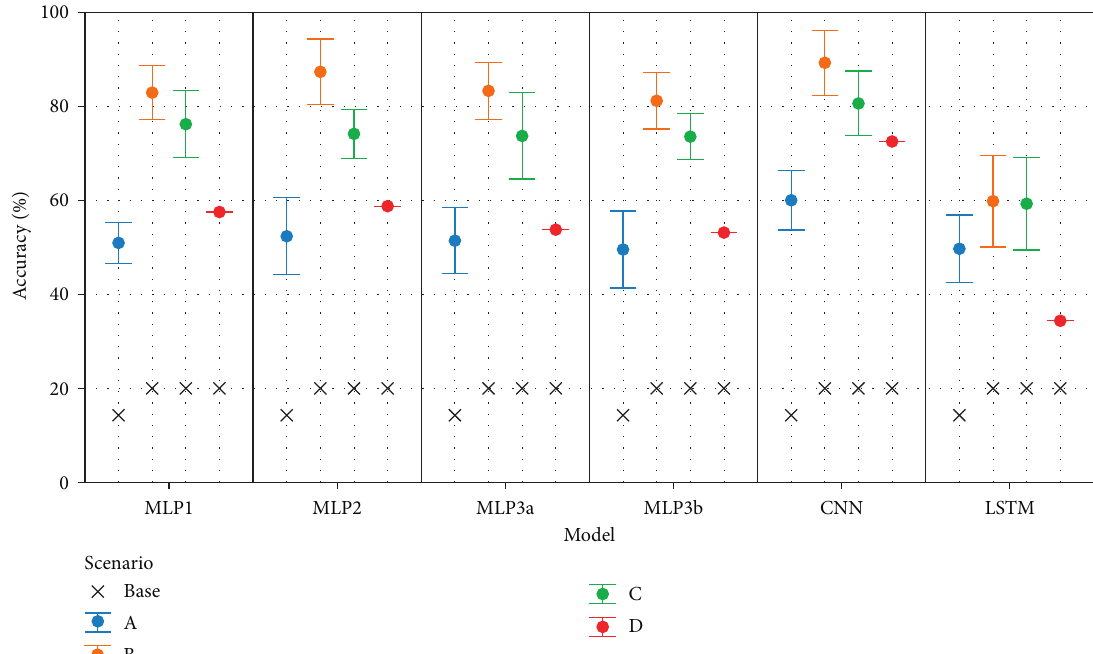
Figure 5: Mean model accuracies with standard deviation (if applicable) for different use case scenarios. Baseline (random) accuracy is denoted as “Base” and is marked in